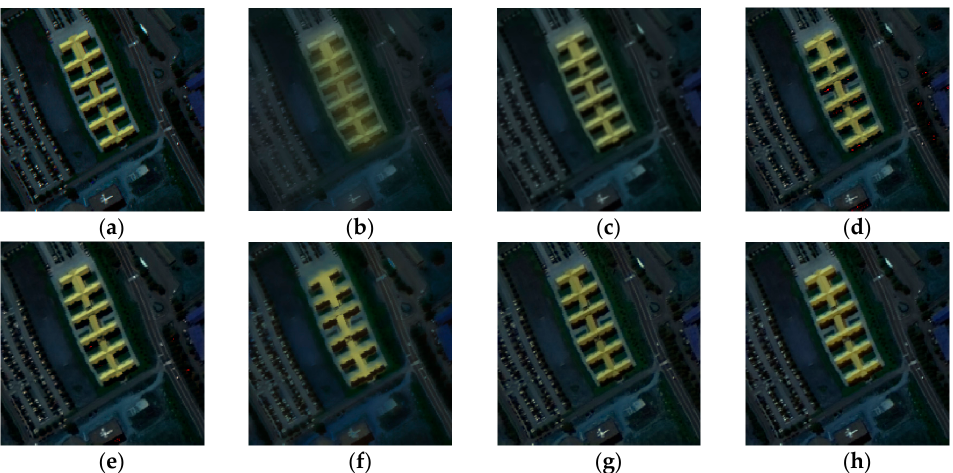
Figure 7. Visual comparison of different hyperspectral pansharpening methods for Paiva University dataset. ( a ) Reference; ( b ) PCA; ( c ) GFPCA; ( d ) HySure; ( e ) MGH; ( f ) CNMF; ( g ) Sparse Representation; ( h ) Proposed.